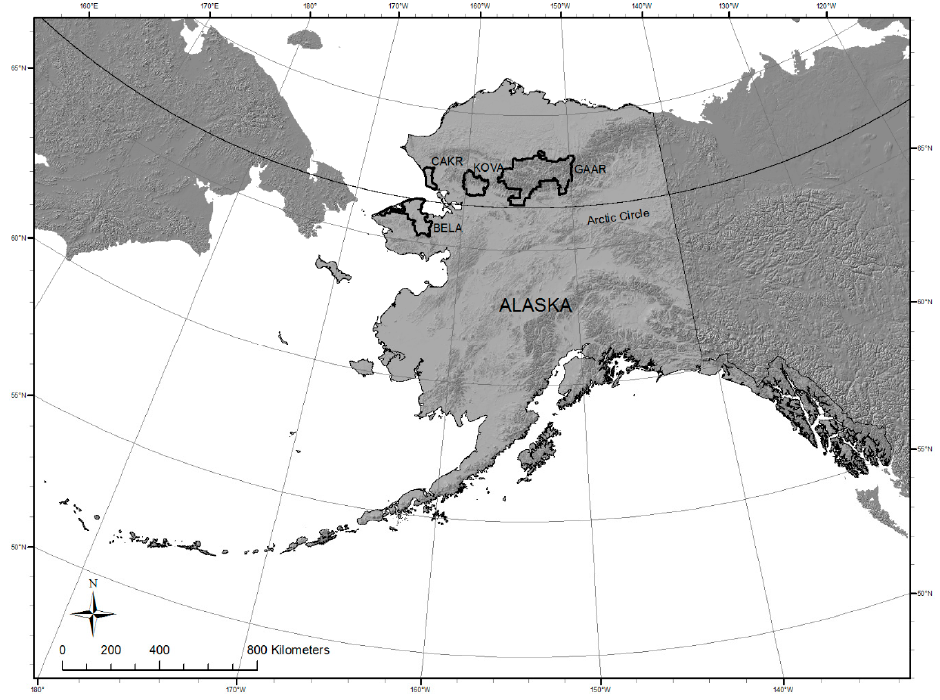
Figure 1. Study location. The boundaries of the National Parks and Preserves are indicated, including from East to West, Gates of the Arctic (GAAR), Kobuk Valley (KOVA), and Cape Krusenstern (CAKR), all in the Arctic Circle, and Bering Land Bridge (BELA) which straddles the boundary of the Arctic Circle.